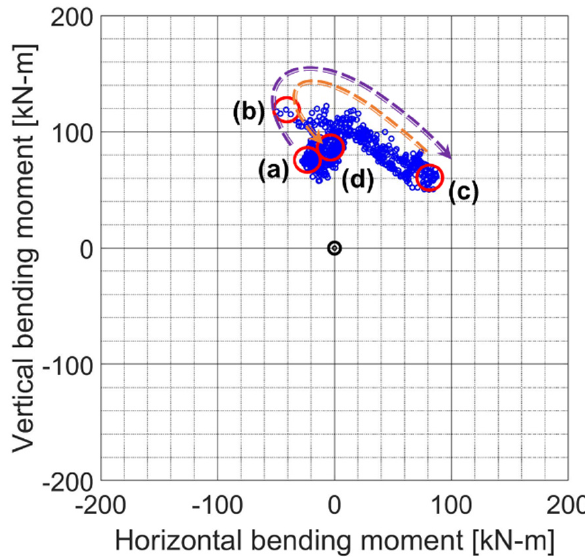
Figure 17. Plot of trajectories obtained during the starboard turn under the fully laden condition. Stage (a): Rudder angle 0-degree: NCR straight going (begin). Stage (b): Rudder angle changes from 0 to 12-degree (starboard). Stage (c): Rudder angle 12-degree: ship’s heading is gradually changing. Stage (d): Rudder angle 0-degree: NCR straight going (end).